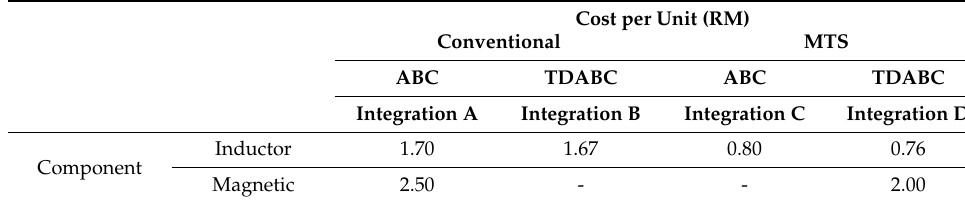
Table 7. Cost through multiple